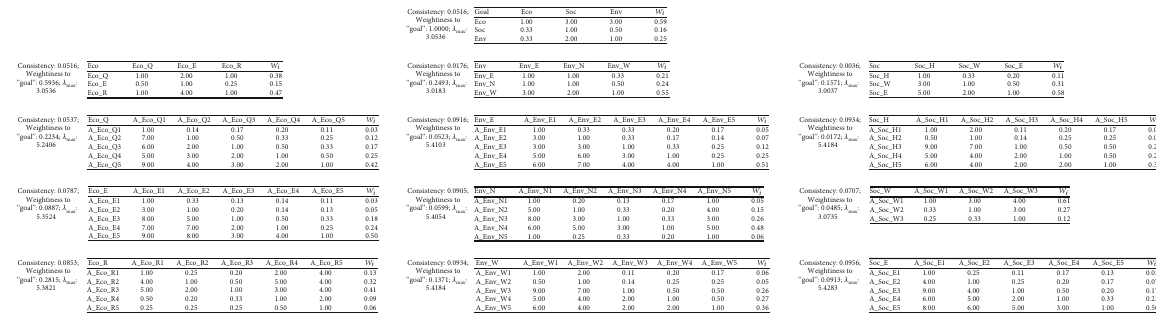
Figure 2: Weights (importance) of criteria, subcriteria and alternatives for the AHP analysis (own work). Table 4: Pro fi les of eight professionals considered for the AHP analysis: SC: supply chain; IM: inventory management; SD: Sustainable Development (own